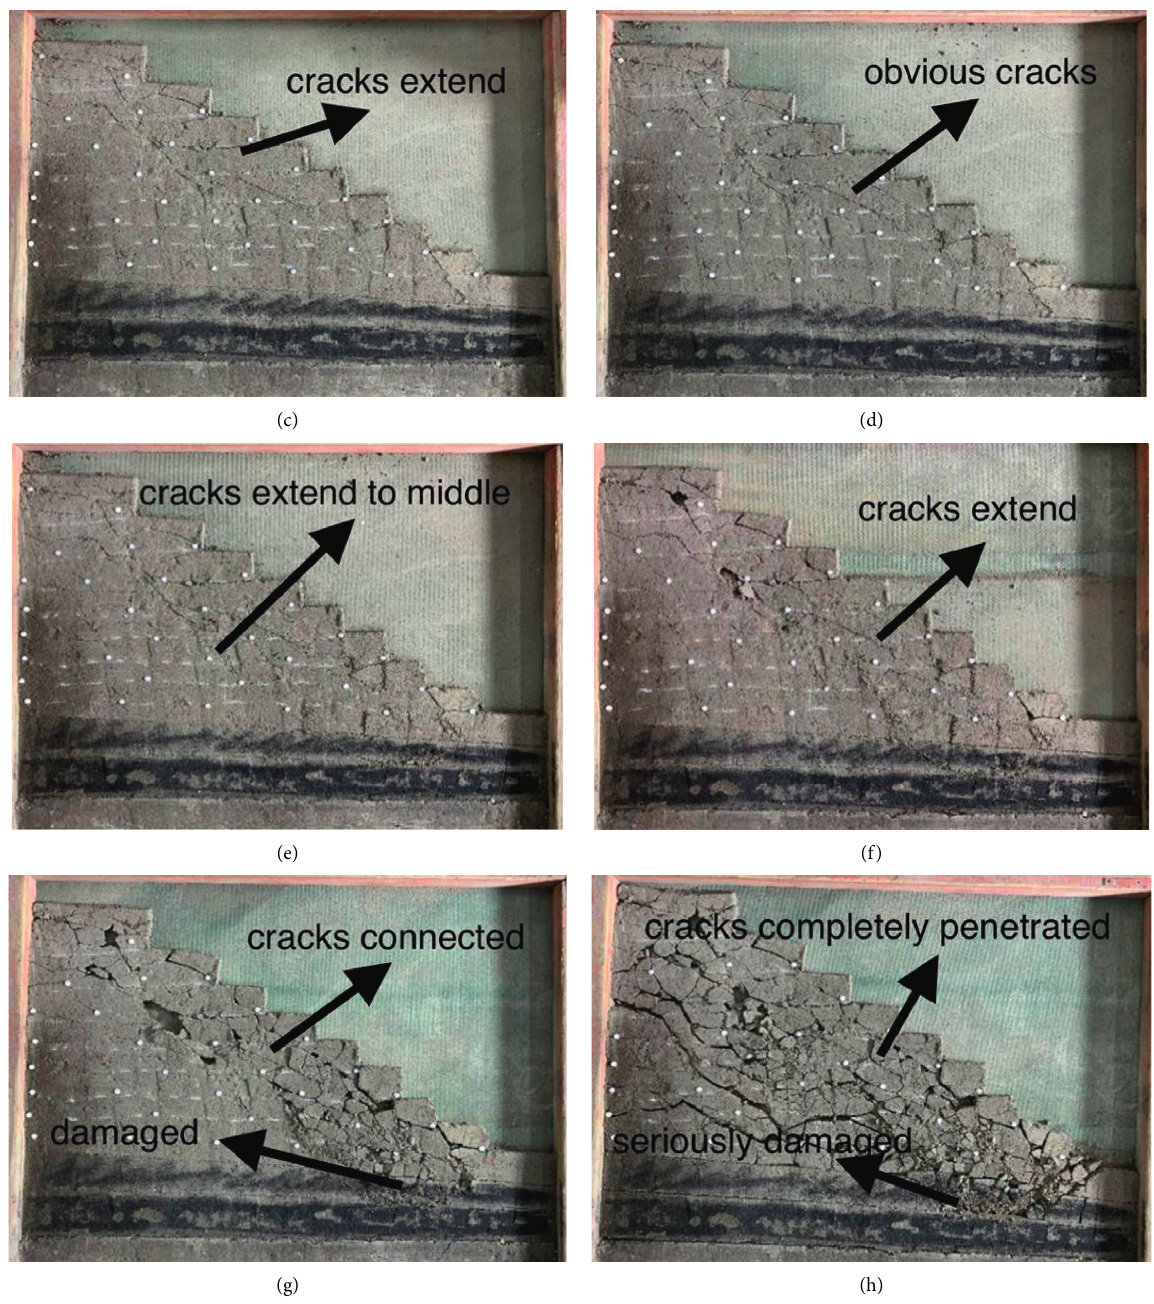
Figure 10: Destruction process of dumping yard. (a) 1.1s. (b) 2.9s. (c) 3.8 s. (d) 5.6s. (e) 7.7 s. (f) 9.6s. (g) 11.2s. (h)